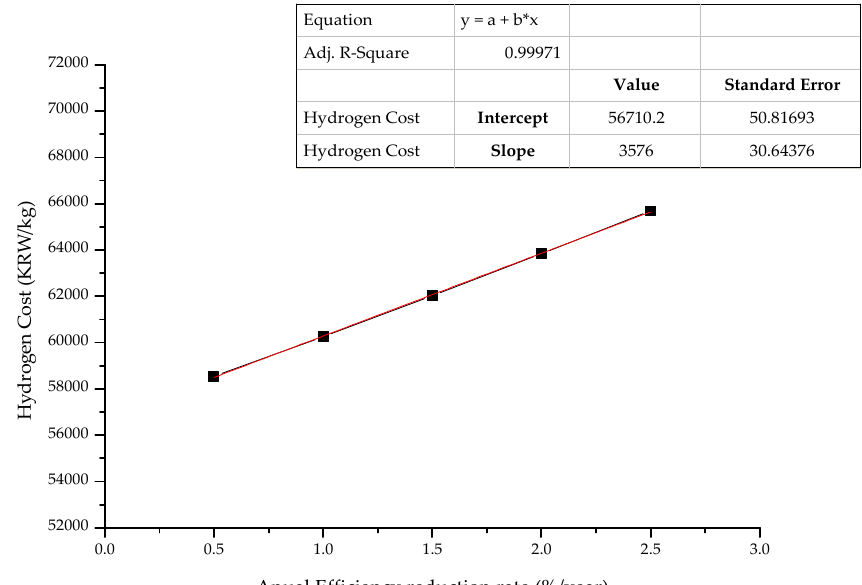
Figure 7. Correlation between annual reduction rate of efficiency for water electrolysis and hydrogen cost *. * x -axis: Annual Efficiency Reduction Rate(%/year), y -axis: Hydrogen Cost(KRW/kg). Solid line: y -values connecting line, Dot line: Regression line.